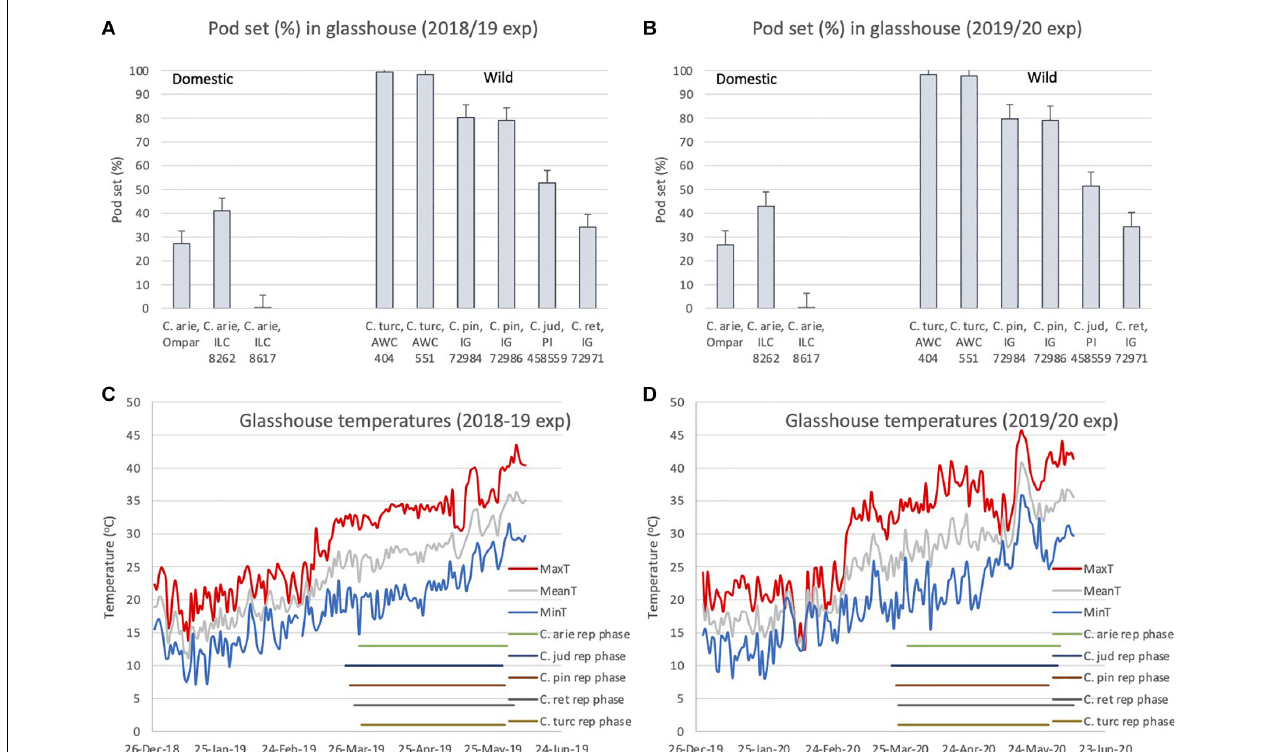
FIGURE 7 | C. turcicum pod set percentage (A,B) under high reproductive phase temperatures (C,D) compared to related annual wild and domestic Cicer species. Data is from Mediterranean cool-season common garden screenhouse comparisons at Akdeniz University, (A,C) 2018/19, (B,D) 2019/20. Error bars represent accession least significant differences (LSD P < 0.05). Reproductive phase lengths (flowering to maturity) are shown individually for each species (B) . Abbreviations: C. arie, C. arietinum ; C. turc, C. turcicum ; C. pin, C. pinnatifidum ; C. jud, C. judaicum ; C. ret, C. reticulatum